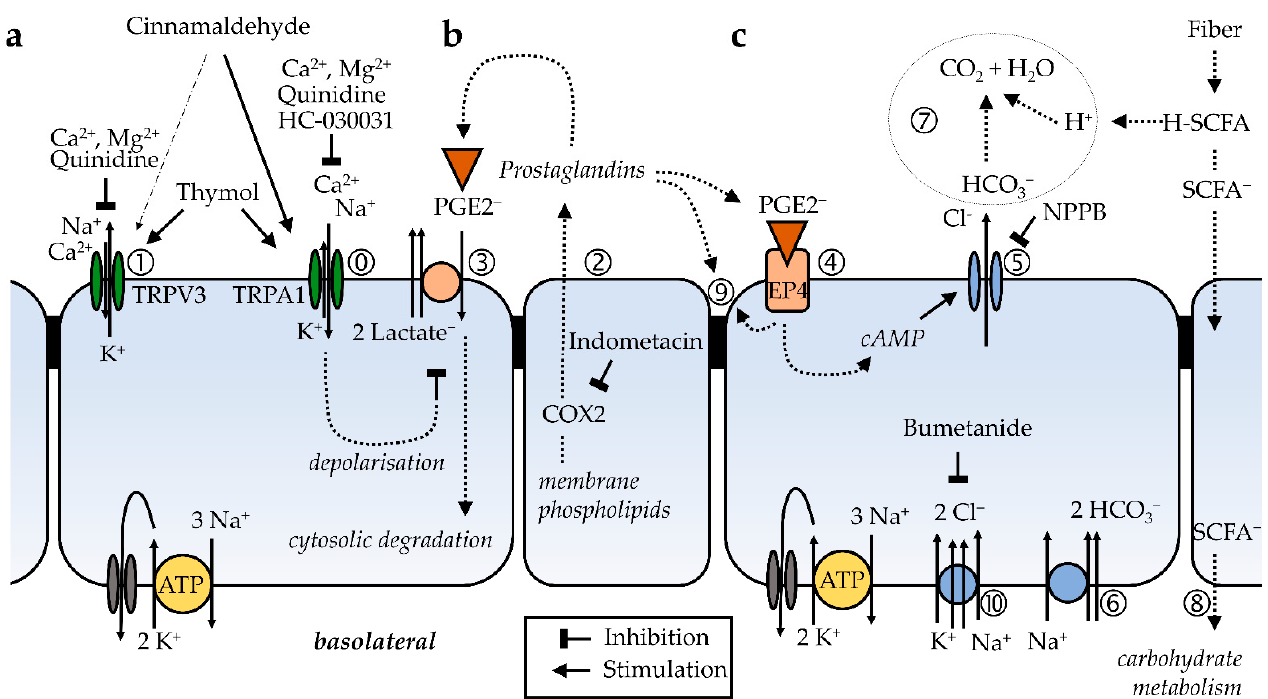
Figure 7. Model of the effects of cinnamaldehyde on the colon, based on the present study and the current literature. ( a ) Cinnamaldehyde opens apical, non-selective TRPA1 channels in the colonic mucosa near the lumen ( ). The selectivity filter of the channel allows both the influx of Na + and Ca 2+ , and a smaller efflux of K + , so that the effects on I sc are small. However, the cell is depolarised and a significant increase in conductance Δ G t is observed, which is reduced by quinidine and enhanced by the removal of divalent cations. The effects of cinnamaldehyde on TRPV3 ( ), which favors efflux of K + over influx of Na + and Ca 2+ , are discrete. Thymol opens both channels. ( b ) Prostanoids such as PGE2 are anions that are synthesized from membrane phospholipids via cyclooxygenase-mediated pathways and secreted into the extracellular space via pathways that are being explored ( ). For prostanoid signalling to end, the anionic prostaglandin has to be taken up into the cytosol via an electrogenic anion exchanger, OATP2A1 (SLCOA1) ( ), after which the prostaglandin is degraded by cytosolic enzymes. Due to the electrogenic nature of the cotransporter, the depolarization of the cellular membrane, as occurs after the opening of TRPA1 channels via cinnamaldehyde ( ), decreases the uptake of prostaglandins and thus increases the extracellular prostaglandin concentration. ( c ) After the binding of the PGE2 to EP4 receptors ( ) expressed by the colonic mucosa, adenylyl cyclase is stimulated, resulting in rising levels of cAMP that open apical CFTR channels ( ). Other anion channels may contribute to the secretion of HCO 3 − , which is driven by the uptake of Na + via basolateral NBCn1 (Slc4a7), NBCe1 (SLC4A4), or NBCe2 (Slc4a5) at a ratio of 1, 2 or 3 HCO 3 − for each Na + ( ). Most of the NPPB-sensitive rise in I sc that is observed after the activation of TRPA1 via cinnamaldehyde can be explained by this mechanism. The secretion of HCO 3 − is important for the buffering of protons formed in the fermentational process ( ), and for the unfolding of mucines in the mucus layer, thus protecting the epithelium. Energy-rich short chain fatty acid anions (SCFA − ) are absorbed via various transport proteins ( ) without challenging cytosolic pH homeostasis. In physiological concentrations, prostaglandins are also thought to have barrier-enhancing properties through interaction with tight junction proteins ( ). Possibly, the secretion of HCO 3 − is highest in cells near the surface, while in the crypts, the expression of NKCC1 (SLC12A2) ( ) predominates. The latter pathway leads to the secretion of Cl − via CFTR, which can result in diarrhea when cAMP levels are pathologically high. Because the gradients favor a unilateral efflux of anions, the opening of CFTR will have higher effects on Δ I sc than those after the opening of TRPA1.